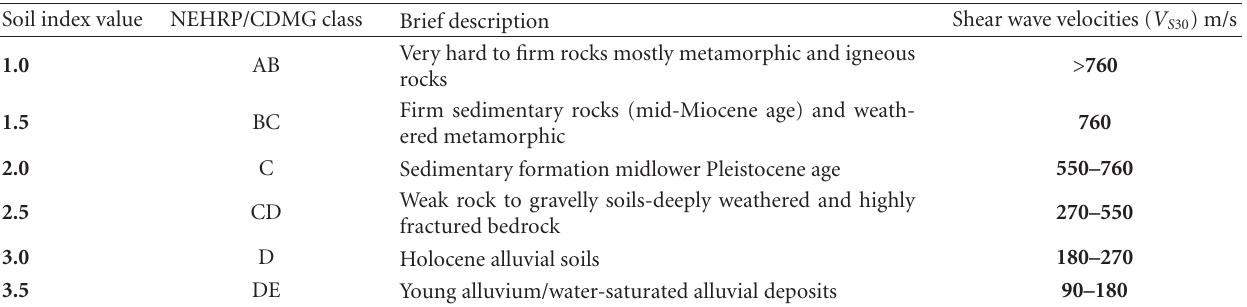
Figure 9: V S 30 (soil index) map of Yemen generated from classification of geological formations. Table 3: Soil classification scheme based on shear wave